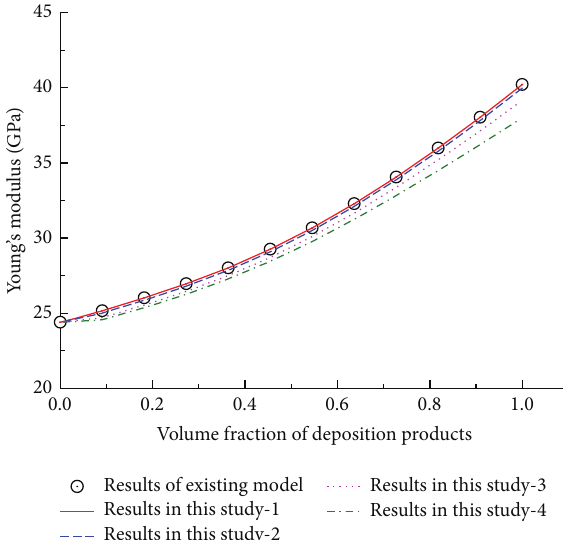
Figure 6: Comparisons of Young’s modulus between our predic- tions and those of existing model [15] during healing process, with 1, 2, 3, and 4 representing results obtained with the first, second, third, and fourth types of ITZ.